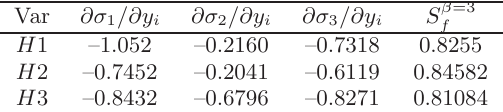
Table 3. Result of reliability-based design optimization. Table 4. Safety factor